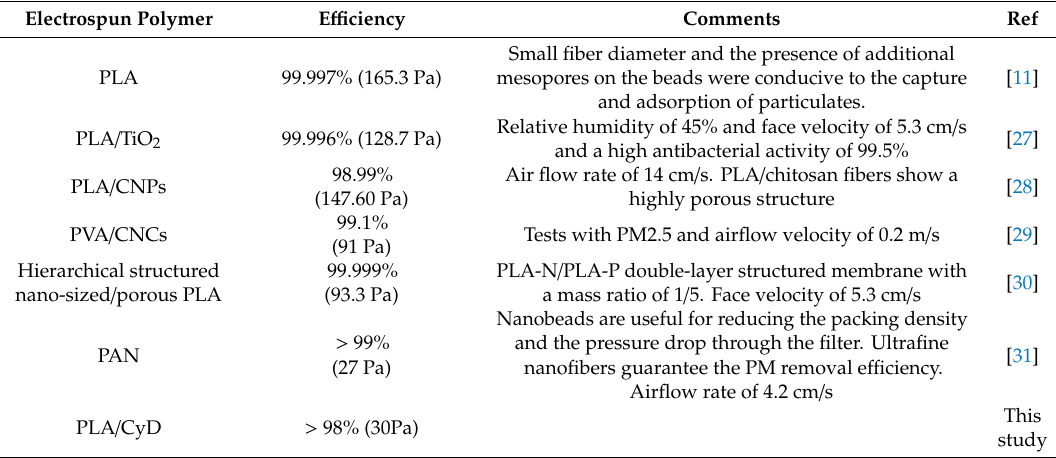
Table 2. Comparison of the obtained filtration results with the ones reported in the literature.